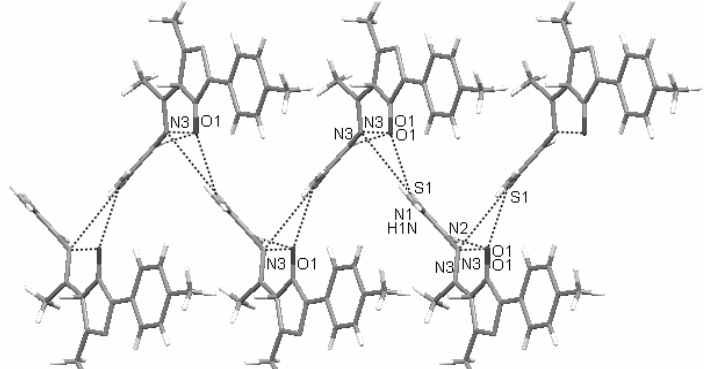
Figure 5. Packing of AcPTMP-ths showing parallel chains linked through hydrogen bonding Synthesis of Novel 4-acylthiosemicarbazon-2-pyrazoline-5-one The reaction of 3-methyl-1-( 4` -methylphenyl)-2-pyrazoline-5-one (PTMP) with acetyl chloride or propionyl chloride were carried out under the ordinary condition. The reaction 4-acyl-2-pyrazoline-5-one with thiosemicarbazide produce Schiff base as carried out in alcohol such as ethanol or methanol at reflux temperature and crystallization by aqueous alcohol for purification. A yellow prismatic crystal of the titled compounds obtained. The formation of 4-acylthiosemicarbazon-2-pyrazoline-5-one was confirmed by spectral data viz. 1 H NMR, 13 C NMR and